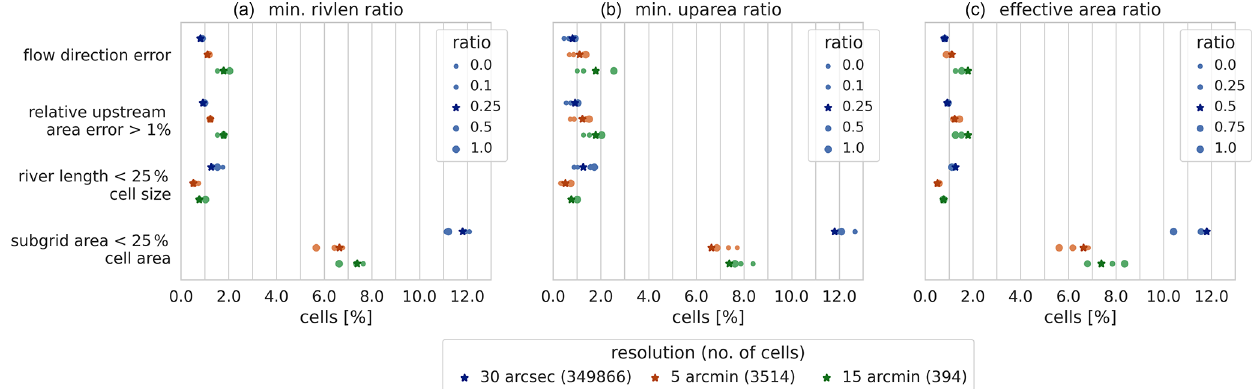
Figure E1. Sensitivity analysis for the minimum river length threshold (a) , minimum upstream area threshold (c) and effective area defini- tion (c) , where the minimum river length threshold and R parameter in the effective area definition are expressed as a ratio of the cell size and the minimum upstream area threshold as a ratio of the cell area. The sensitivity is tested for four metrics ( y axis) and expressed as a percentage of the total basin cells ( x axis). The default ratio is shown with a star and alternative ratios with dots for which the size is scaled with the ratio